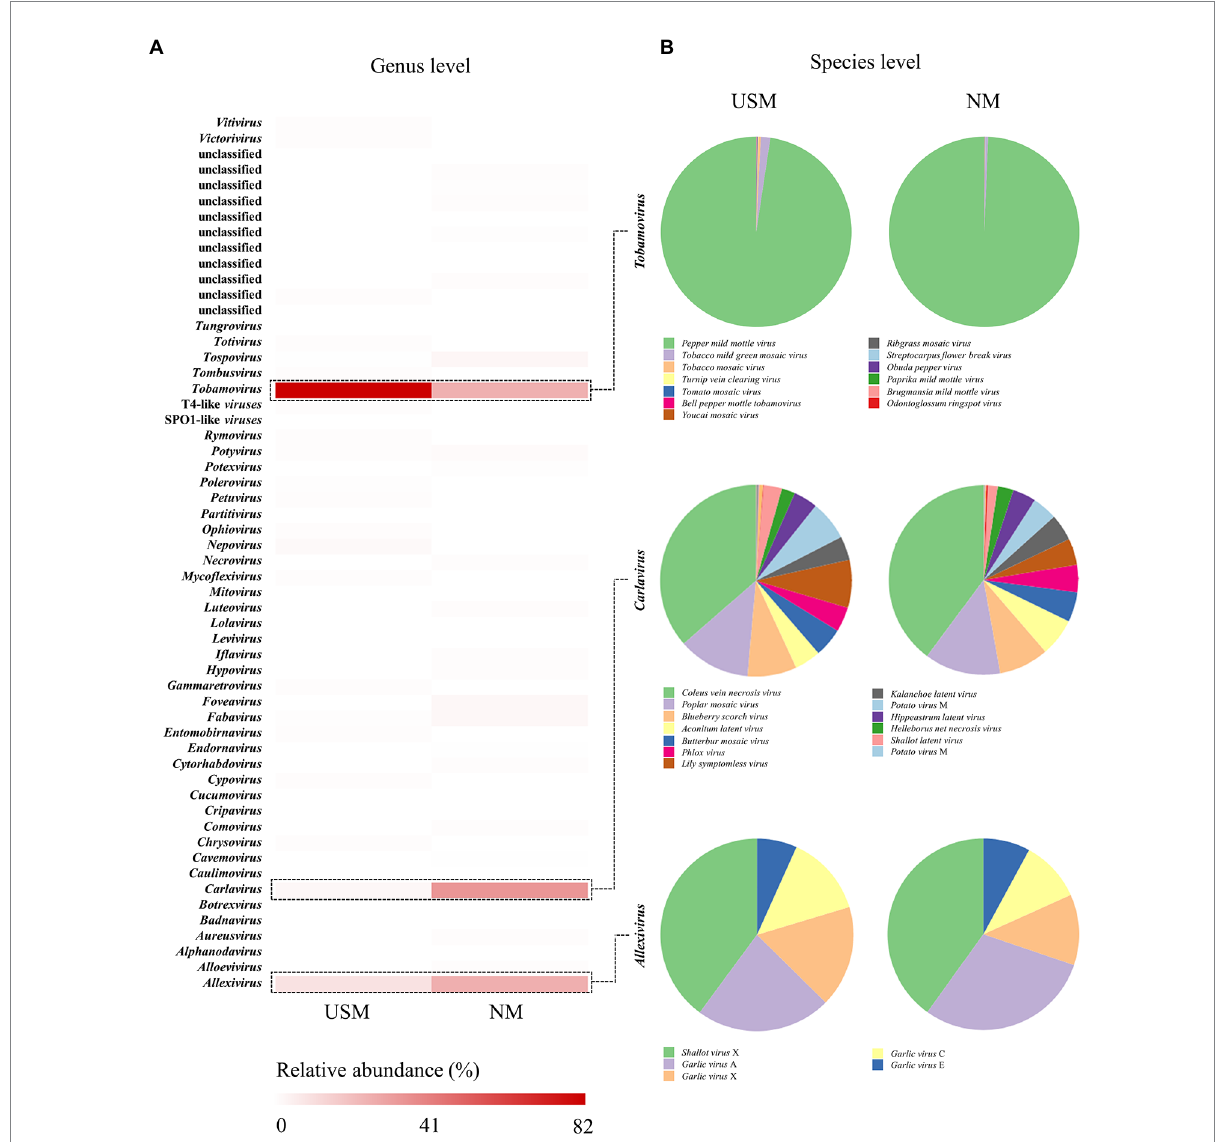
FIGURE 3 Relative abundance profiling of RNA virome analyzed in USM and NM. Relative abundance profiling of RNA virus in the genus level was analyzed using a heat map (A) , and the red color intensities of panels are proportional to the operational taxonomic unit (OTU) abundance (max. 82%). Relative abundance profiling of species levels related to Tobamovirus , Carlavirus , and Allexivirus was analyzed using pie charts (B)